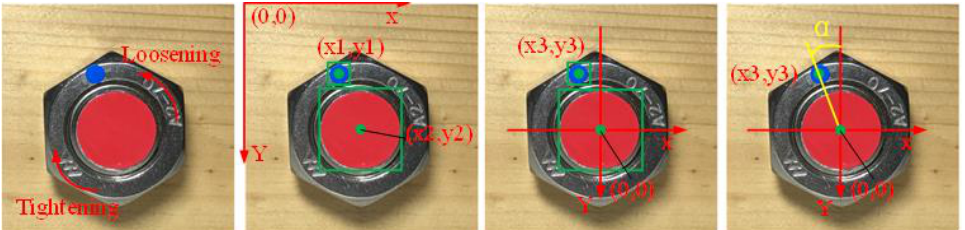
Figure 4. Rotation angle calculation process.